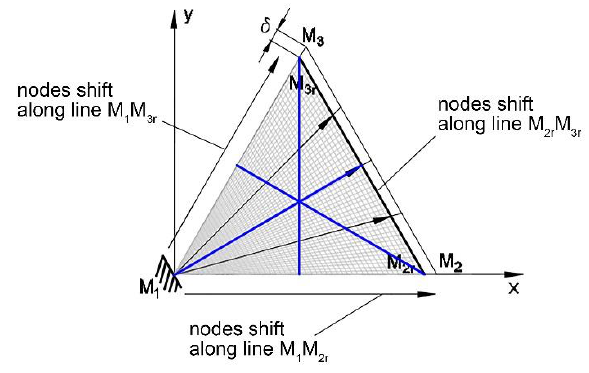
Fig. 11. 1 st step of the knitted mesh fabric